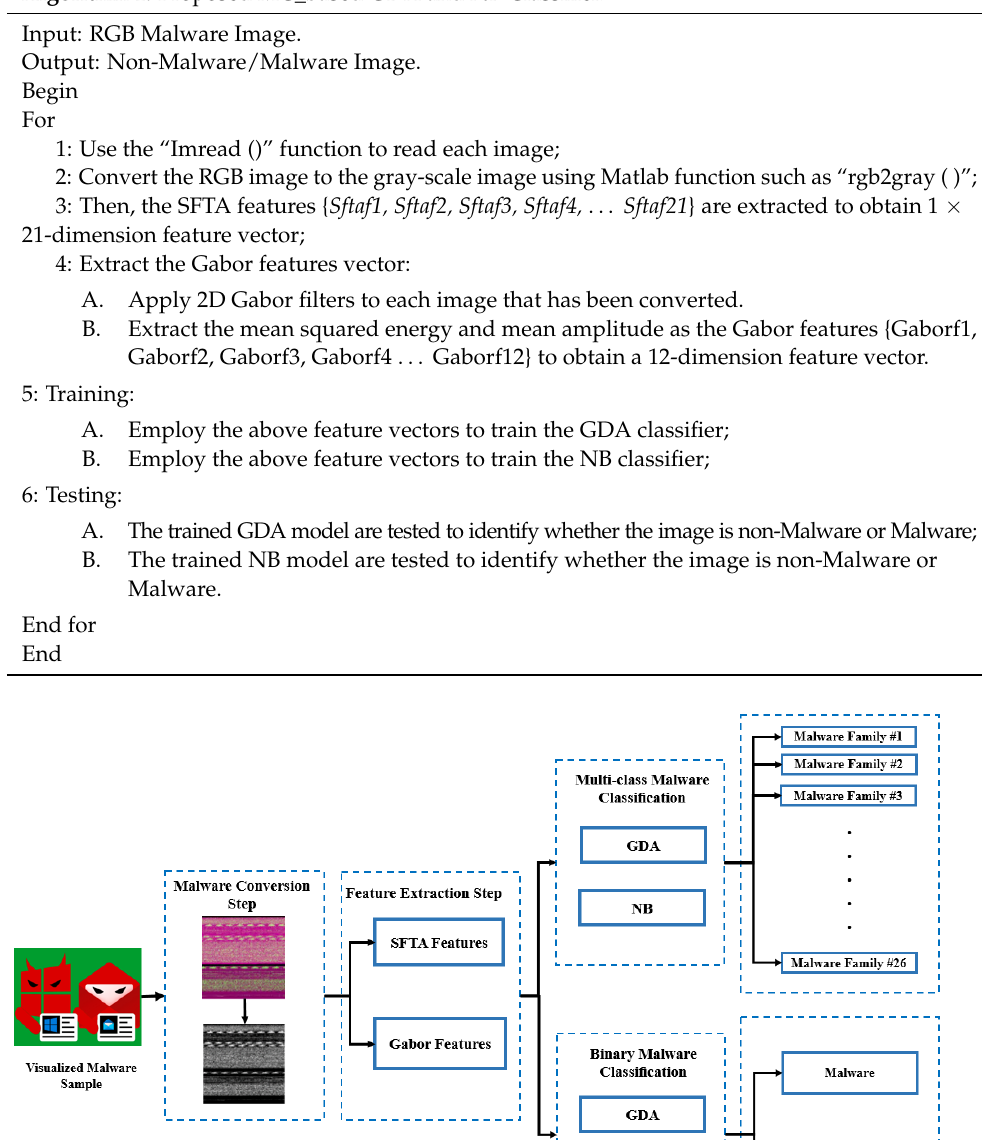
Figure 3. A two-dimensional Gabor filter with eight orientations and five scales [31].